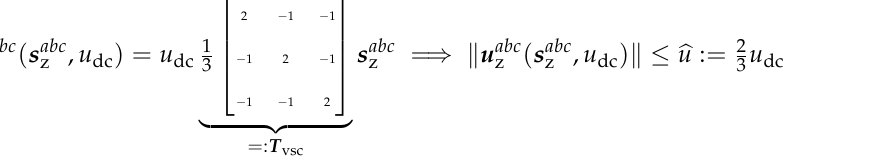
s,f ). ∈ { } to the line filter. The f